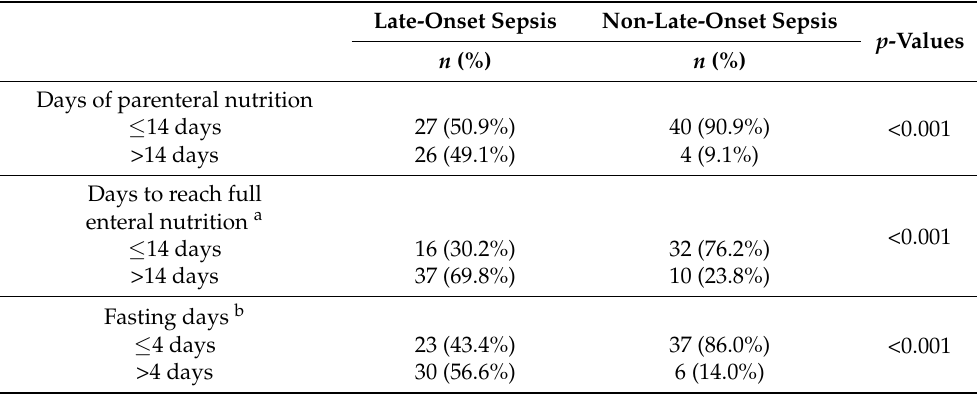
Table 2. Nutritional variables associated with late-onset sepsis ( n = 97).